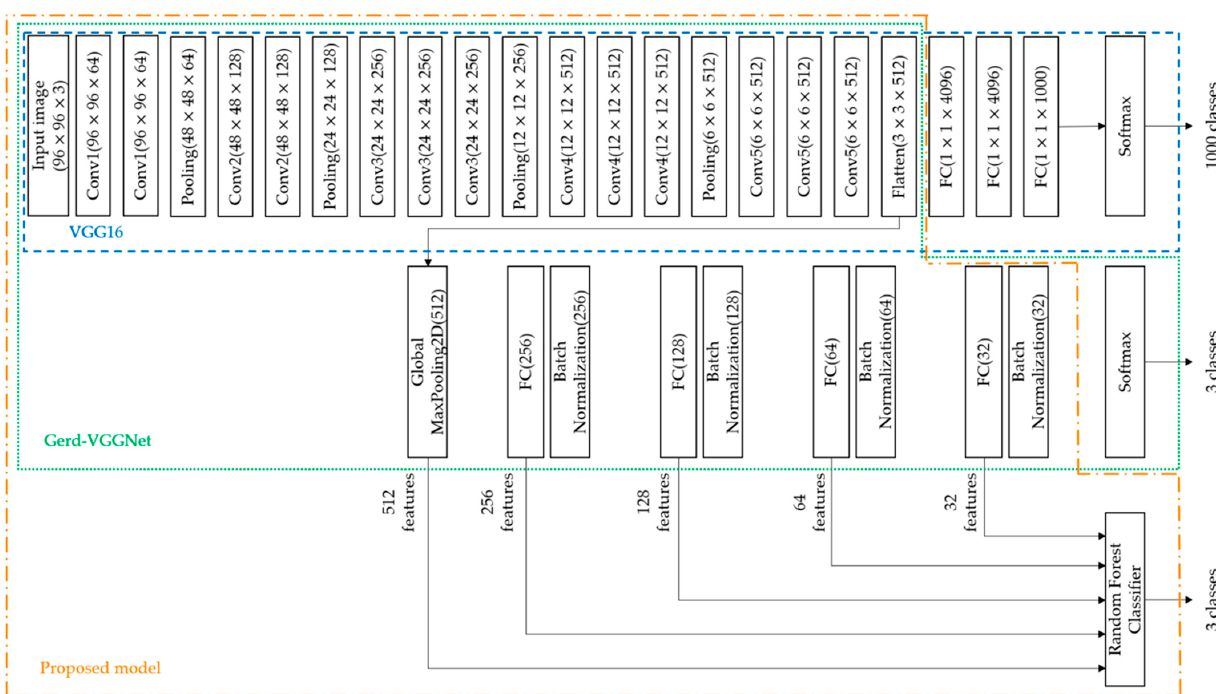
Figure 2. Study flowchart.